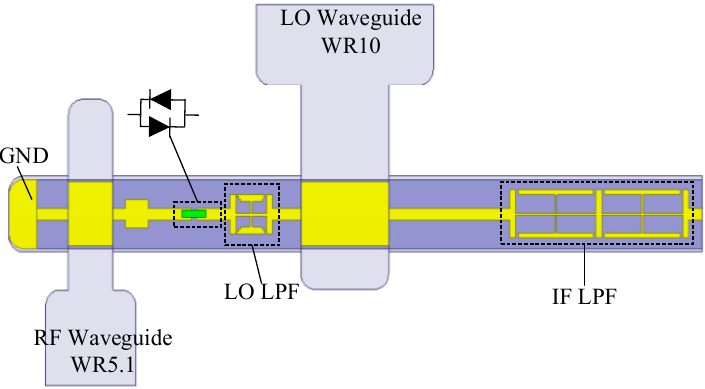
Figure 6. circuit topology of mixer 2. Figure 6. Circuit topology of mixer